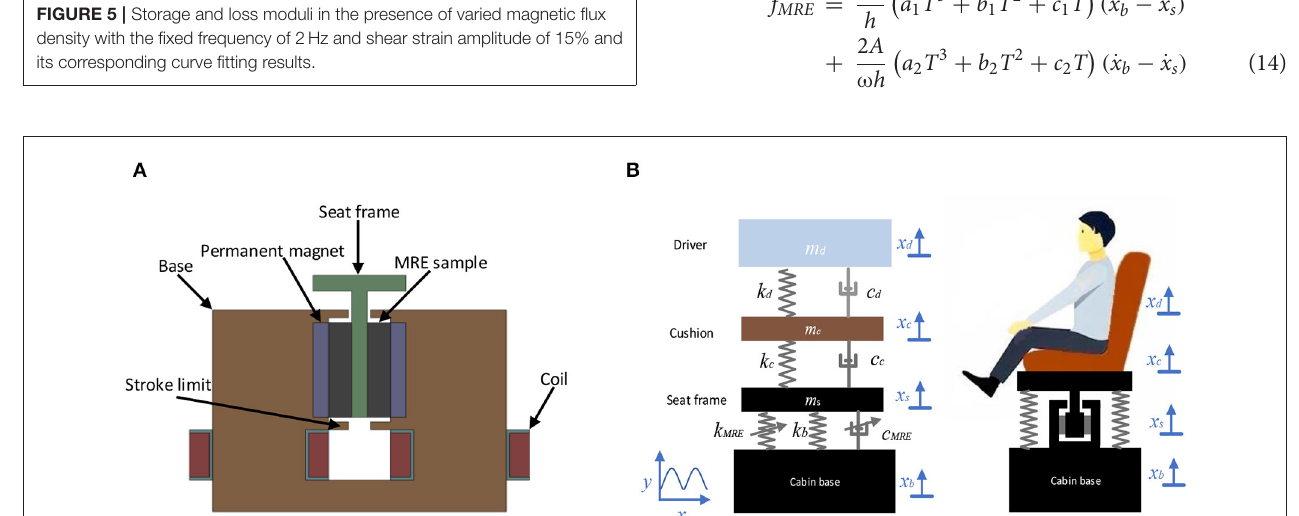
Frontiers in Materials |